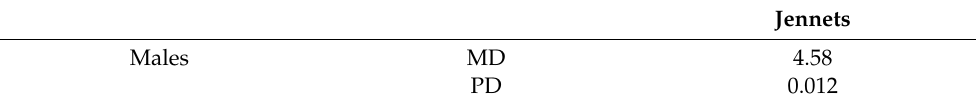
Table 4. Mahalanobis distances (MD) and Procrustes distances (PD) among the sex categories (jennets and